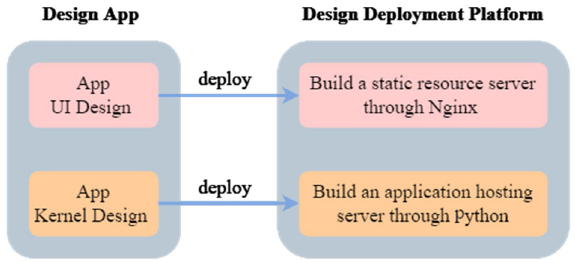
Figure 4. Application design introduction.